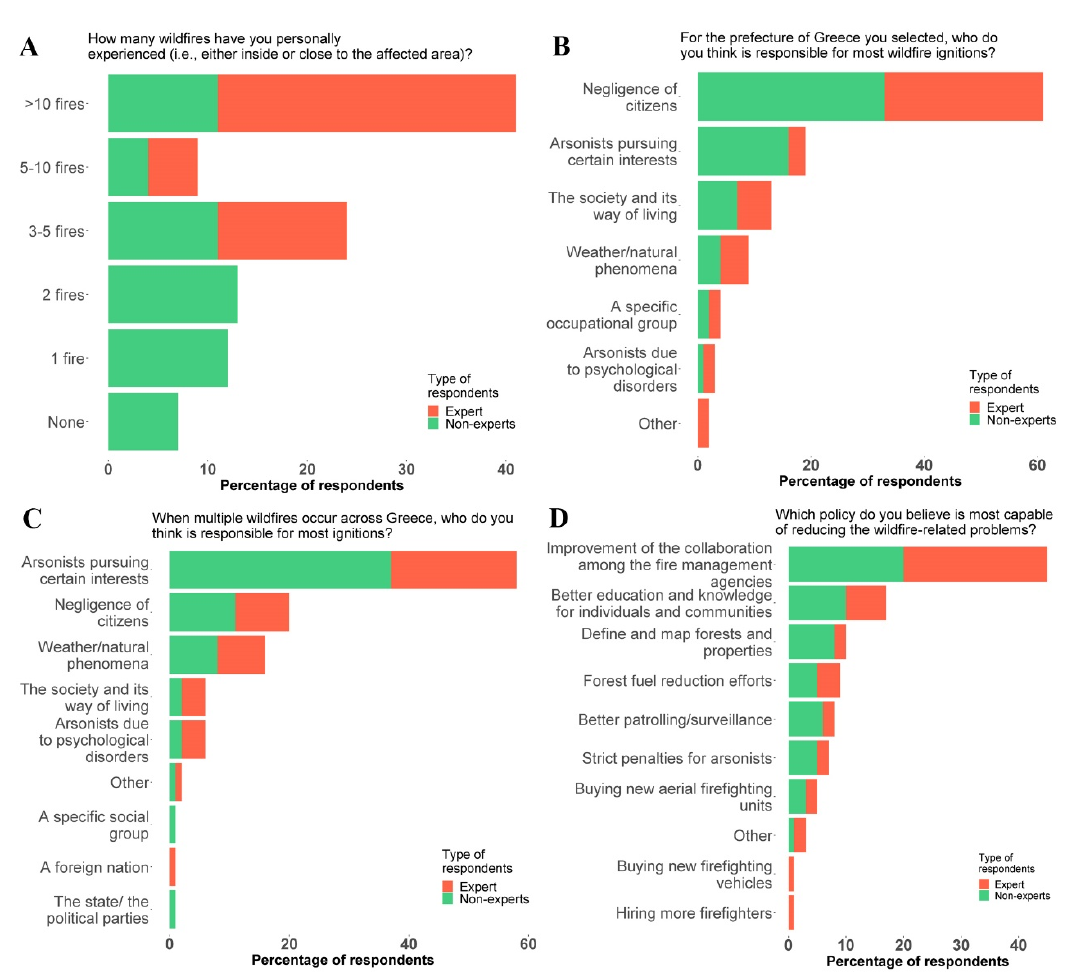
Figure 2. Survey response summary for three of the six general questions and one personal question. ( A ) How many wildfires have you personally experienced (i.e., either inside or close to the affected area)? ( B ) For the prefecture of Greece you selected, who do you think is responsible for most wildfire ignitions? ( C ) When multiple wildfires occur across Greece, who do you think is responsible for most ignitions? ( D ) Which policy do you believe is most capable of reducing the wildfire-related problems?